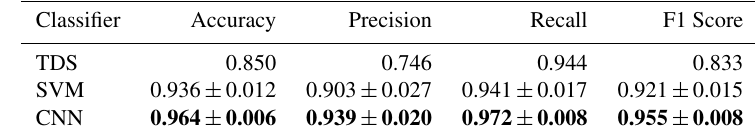
Table 1. The TDS, SVM and CNN classification performance metrics: accuracy, precision, recall and F1-score. The SVM and CNN scores and error values are the mean and the standard deviation across 10 training runs. The bold numbers indicate statistically enhanced perfor- mance with a significance level of 0.01, computed using a t -test.